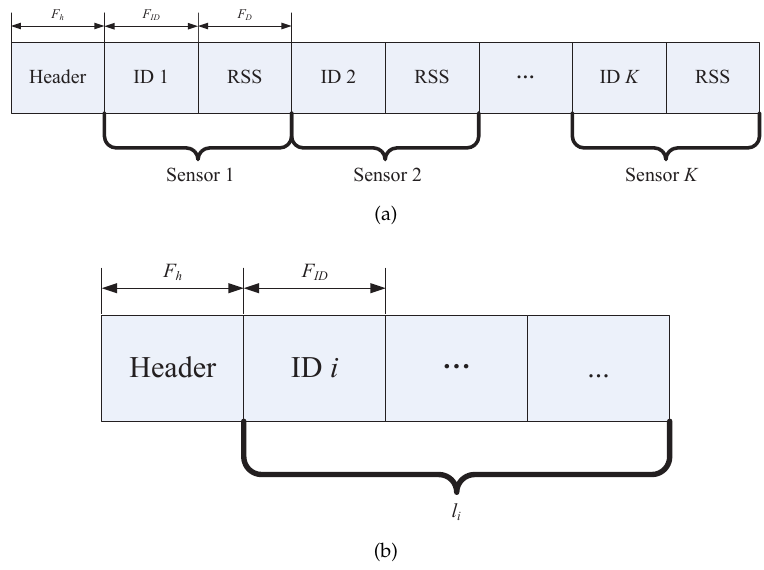
Figure 3. The frame structure of transmitted packet in the ( a ) traditional mode; and ( b ) binary